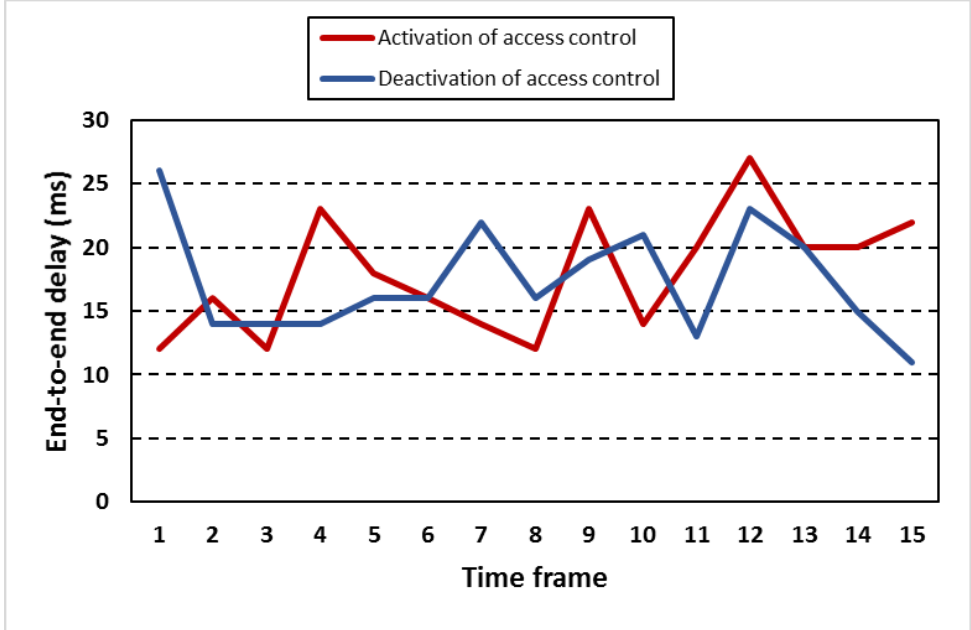
Figure 18. Average end-to-end delay between a smart phone and IoT